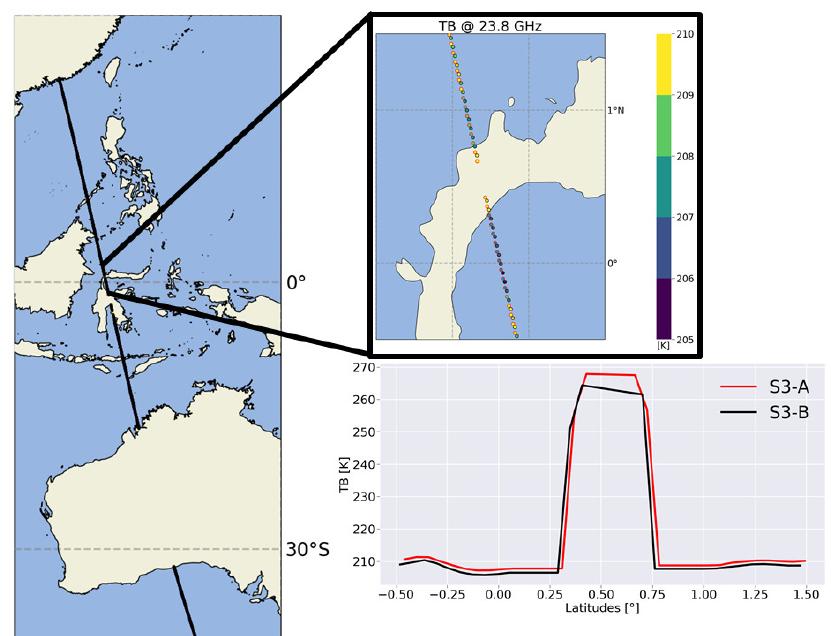
Figure 3. 23.8 GHz brightness temperatures observations from Sentinel-3A (red) and Sentinel-3B (black). 12 October 2018, 13:36, orbit 366, cycle 36 (S3-A) and cycle 13